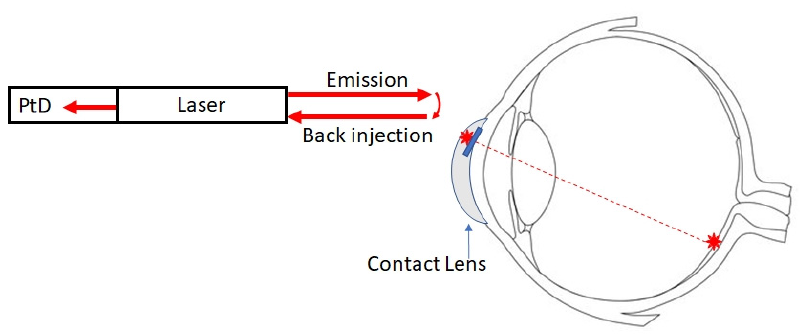
Figure 7. Refractive error measurement by self-mixing interferometry.